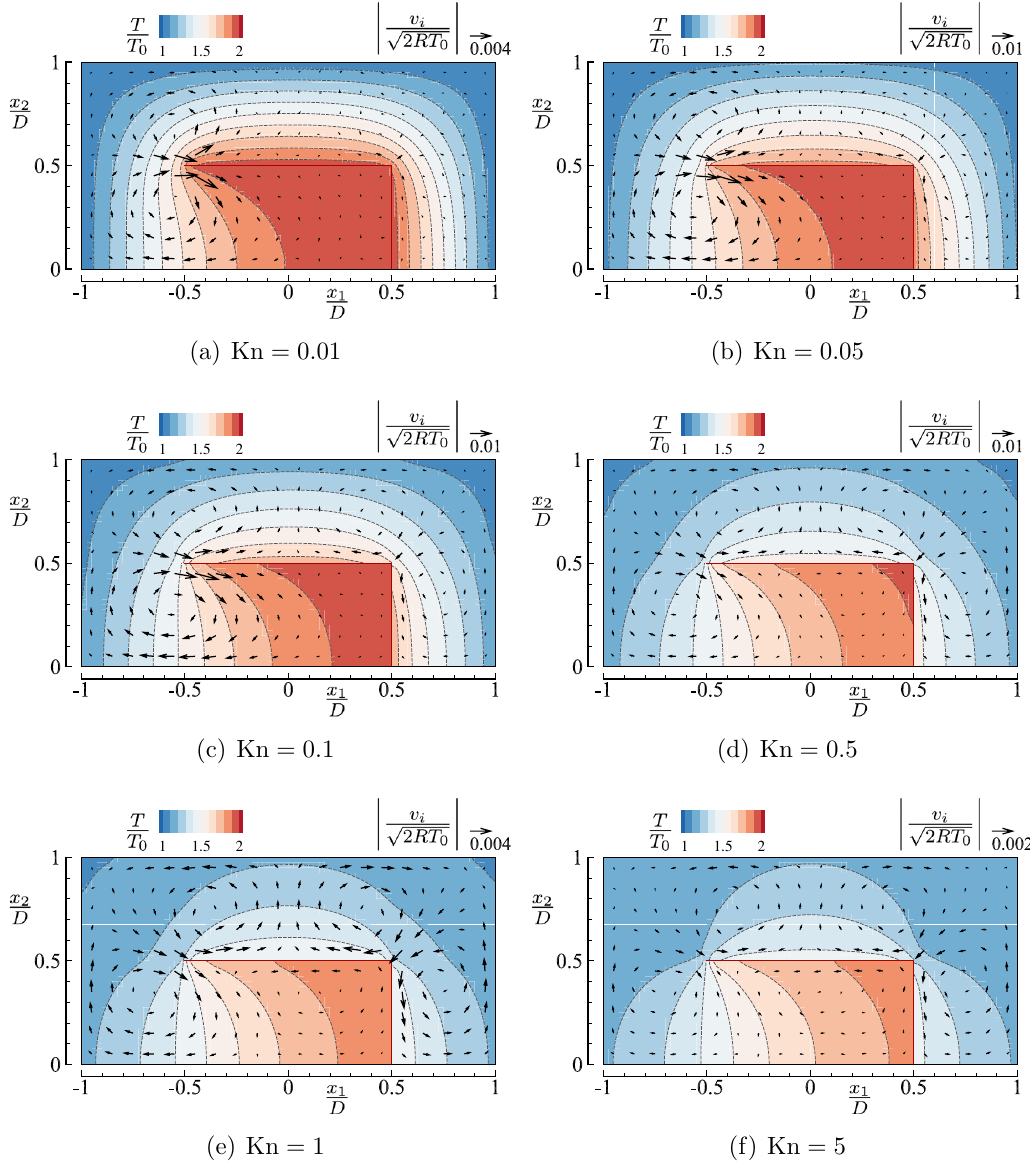
Figure 4. Flow velocity vector ( v 1 , v 2 ) and contour map T in the case of a single square-U body in a closed 2 , H / D 2 , and L / D 1 ) for typical Knudsen numbers Kn vessel ( T 1 / T 0 = = = 0.5, ( e ) 1, and ( f ) 5. Note that the magnitude of the reference vector is different in panels ( a ), ( e ) and ( f